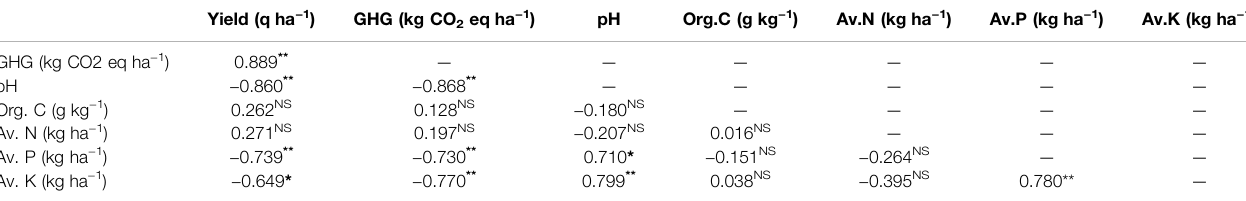
TABLE 5 | Correlation among yield, total GHG emission, and various soil properties (wheat).